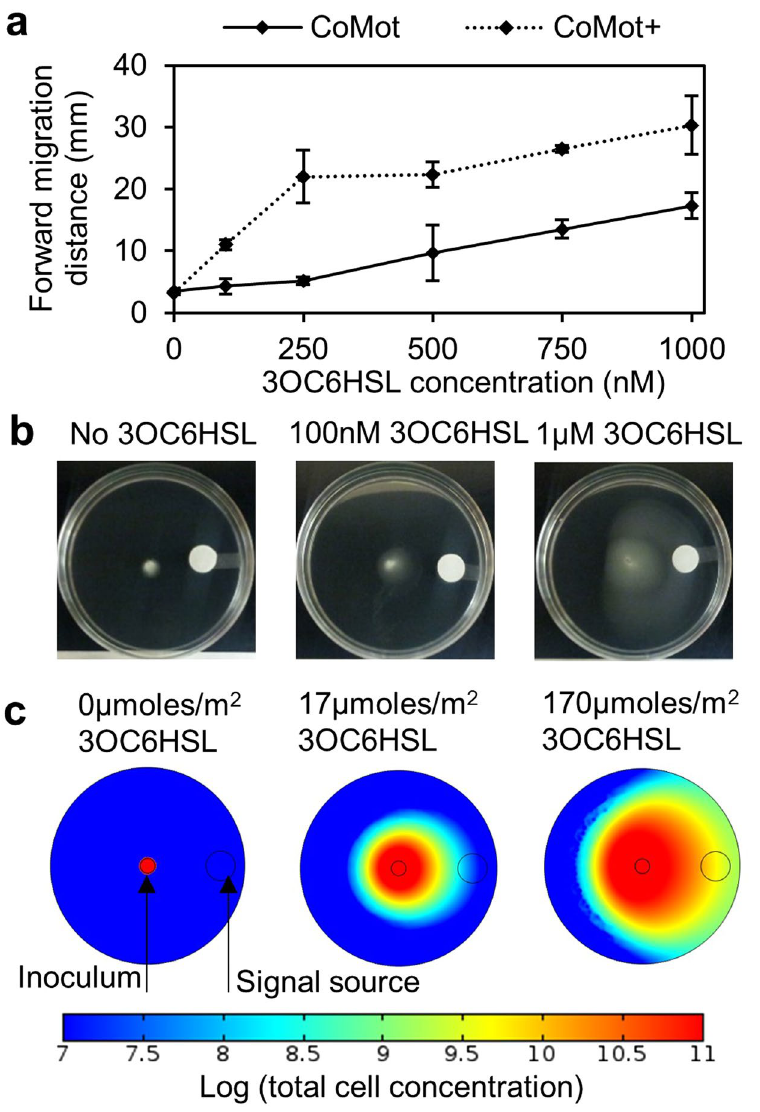
Figure 3. Motility assays and simulations show 3OC6HSL-dependent directional movement of cells in a 3OC6HSL gradient: ( a ) 3OC6HSL gradients were established by adding 0–0.02 μ moles of 3OC6HSL on a Whatmann membrane and allowing it to diffuse for 8 h. CoMot and CoMot + cells were then inoculated at the centre of the plate. The forward migration distance was measured as the distance between the inoculation point and the visible edge of migration of cells up the signal gradient after 24 h of incubation at 30 °C. Error bars represent one standard deviation from the mean forward migration distance of three biological replicates. ( b ) Representative images of plates inoculated with CoMot + cells. ( c ) Results from simulation of the migration response of cells in a similar set up as in (b). Signal gradients were simulated by using 0, 17 or 170 μ moles/m 2 of the signal near the edge of the plate. 3.5 * 10 7 CoMot + cells/m 2 was used as the inoculum at the centre of the plate. The log 10 of the total cell concentration after a simulation time of 24 h is shown in the